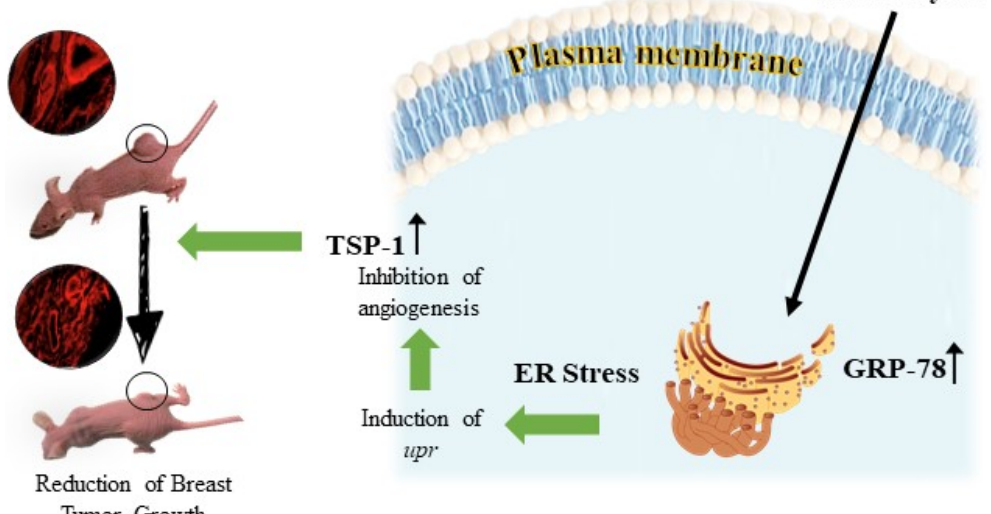
mouse Figure 6. Graphical summary of Tunicamycin action on breast tumor reduction in a pre-clinical mouse model.